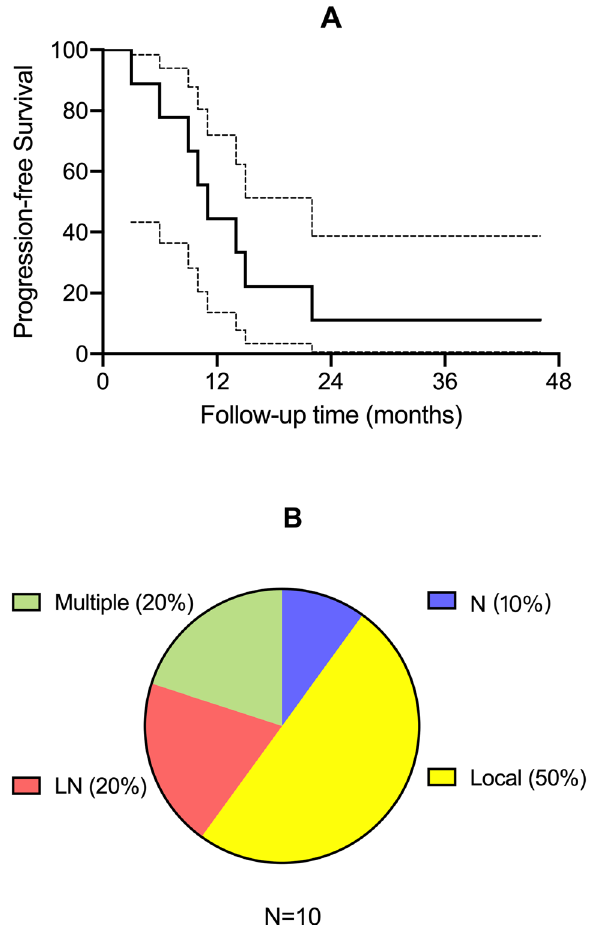
Figure 1. Progression-free survival and recurrence patterns of abdominal wall clear cell cancer. (A) Kaplan– Meier curve of progression-free survival for abdominal wall clear cell cancer. ( B ) Distribution of relapse sites, including local recurrence, LN (lymph node metastasis) and multiple sites. N represents no recurrence.